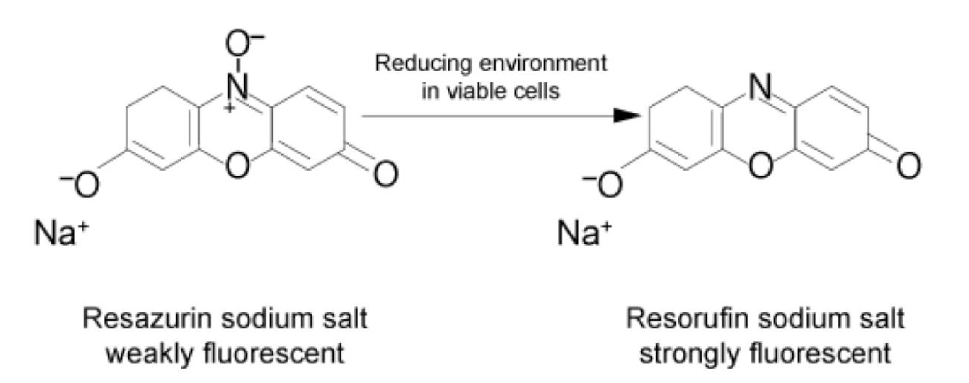
Figure 3. Measurement of metabolic activity. The measurement is performed by means of ubiquitous reducing agents in cells (NADH and NADPH) with of a vital probe (resazurin). Resazurin is reduced via the aerobic respiration of metabolically active cells, changing resazurin to resorufin, a reaction that fluoresces when exposed to green light.